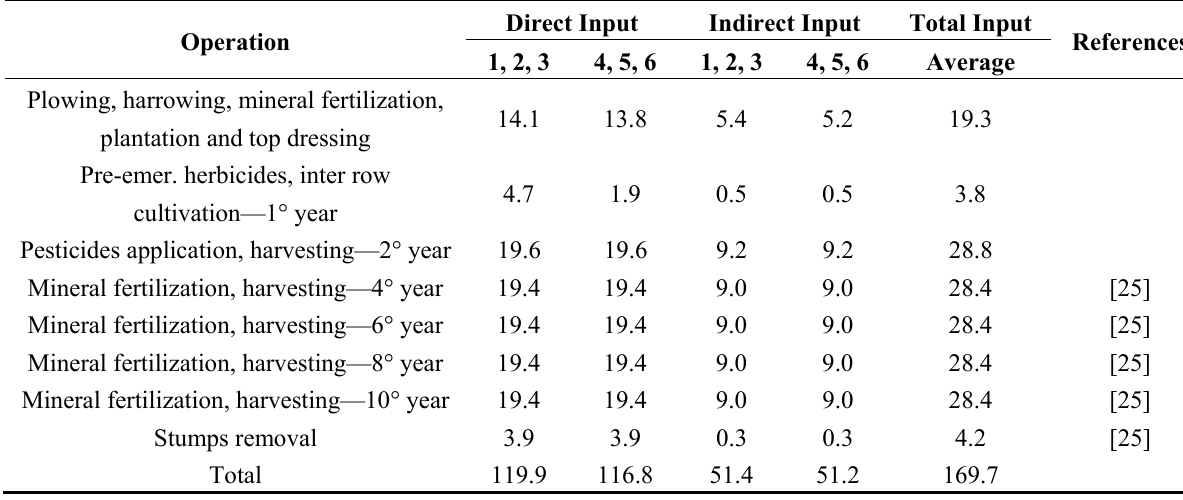
Table 8. Energetic inputs of total productive cycle of plantation (GJ·ha − 1 ) (1: Clone AF2, single row; 2: Clone AF6, single row; 3: Clone Monviso, single row; 4: Clone AF2, twin rows; 5: Clone AF6, twin rows; 6: Clone Monviso, twin